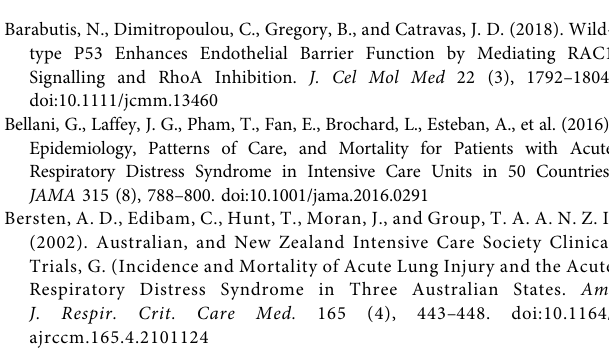
Supplementary Figure S1 | Herb-Component-Target Network of Lianhua Qingwen. Diamond nodes represent genes; circle nodes represent herbs; and the herb is named by acronym. Hexagon nodes of the same color that make a circle around herb represent components of the herb; and the components are named by acronym of corresponding to the herbs. Detailed information of the components are provided in Supplementary Table S1 | The remaining hexagon nodes represent a common component of two or more herbs. A, kaempferol; B, quercetin; C, beta- sitosterol; D1, sitosterol; D2, stigmasterol; E1, luteolin; E2, mairin; F1-F14, the common component of two herbs. The size of genes from large to small is arranged in descending order based on their degree values. Supplementary Figure S2| The 11Ingredient-80 overlappinggenes PPInetworks of (A) Lianqiao, (B) Jinyinhua, (C) Mahuang, (D) Kuxingren, (E) Banlangen, (F) Guanzhong, (G) Yuxingcao, (H) Guanghuoxiang, (I) Dahuang, (J) Hongjingtian, and (K) Gancao. Elliptical nodes delineate ingredients. Circle nodes represent components. They are named in the same way as those in Supplementary Figure S1 . Diamond nodes delineate putative targets in 80 overlapping